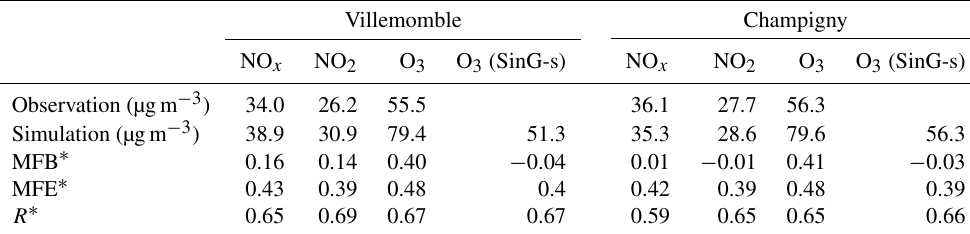
Table B3. Statistical indicators of the comparison of simulated hourly concentrations of NO 2 , NO x , and O 3 in the SinG simulation to the concentrations measured at the urban background air monitoring stations of Villemomble and Champigny. The “O 3 (SinG-s)” corresponds to the ozone concentrations from the SinG-s simulation using the adjusted input data including “corrected” O 3 boundary conditions. MFB and MFE in the O 3 concentration of the SinG simulation are strongly reduced using the corrected boundary conditions. However, the correlation coefficients do not change between the SinG and SinG-s simulations because the O 3 concentrations in the two simulations show very similar temporal